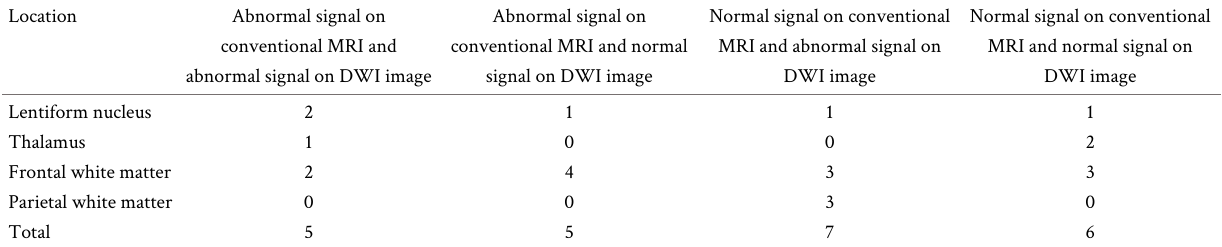
Table 1. Normal and abnormal performance in conventional MRI and DWI of neonates in the HIE group. Location